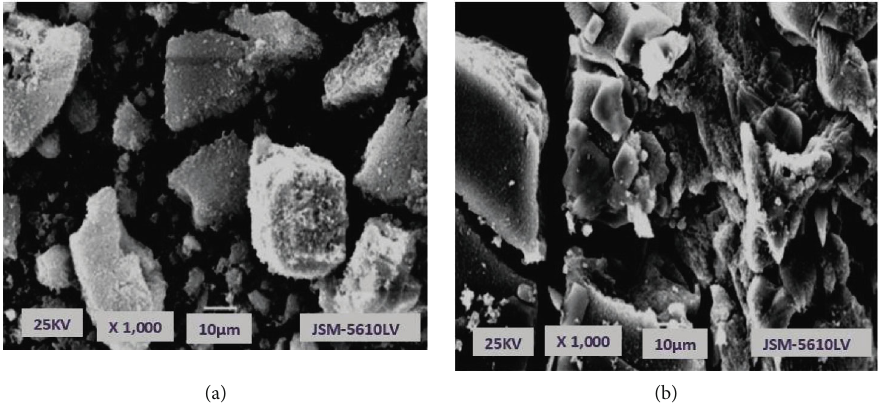
Figure 16: SEM analysis images of calcium phosphate scale (a) without CNS-PESA and (b) with